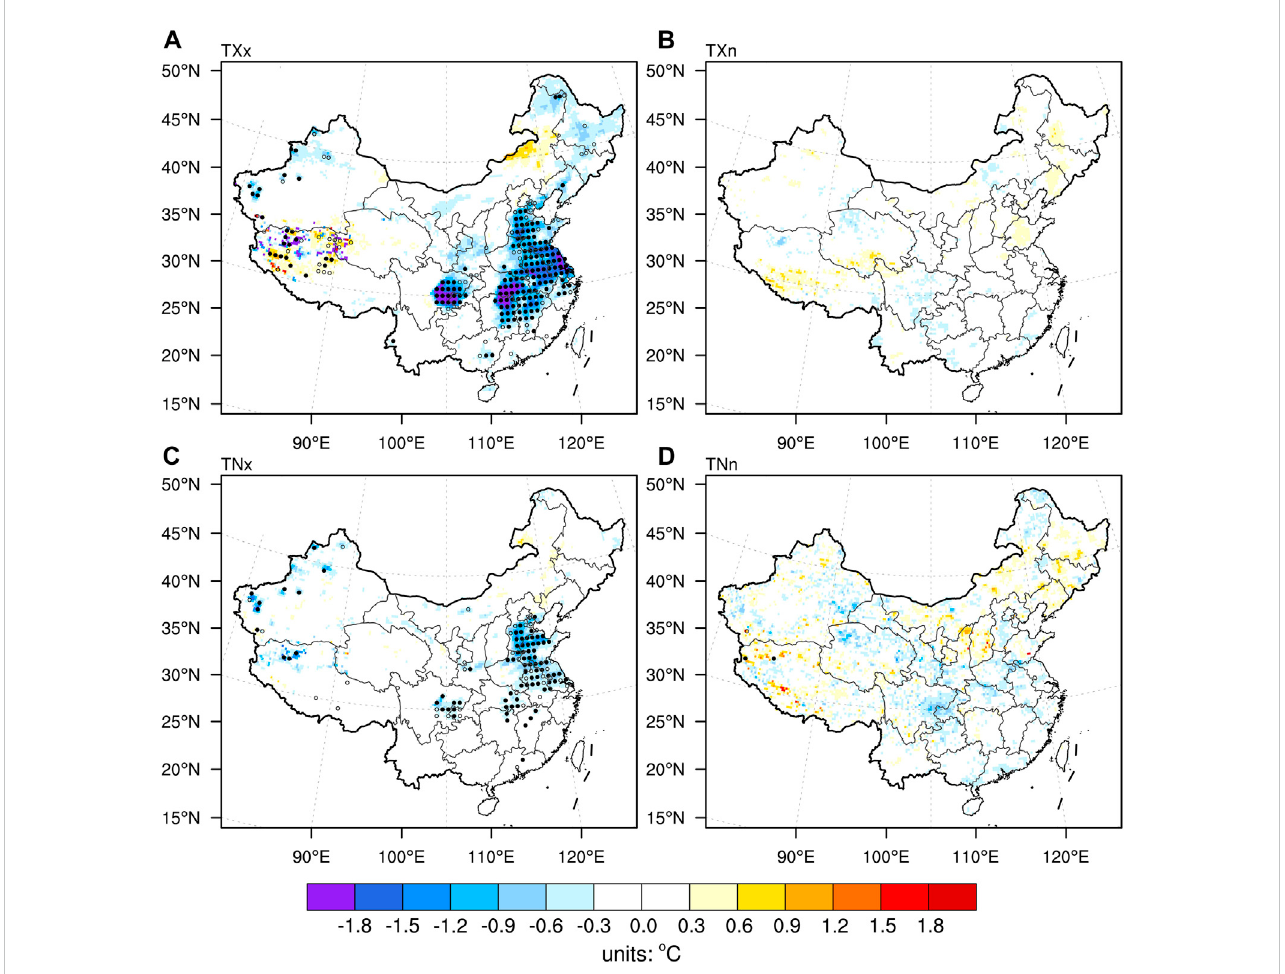
FIGURE 4 Irrigation-induced changes in multiyear mean absolute indices (units: ° C): (A) annual maximum value of daily maximum temperature (TXx), (B) annual minimum value of daily maximum temperature (TXn), (C) annual maximum value of daily minimum temperature (TNx) and (D) annual minimum value of daily minimum temperature (TNn). The meanings of solid and hollow dots are the same as Figure